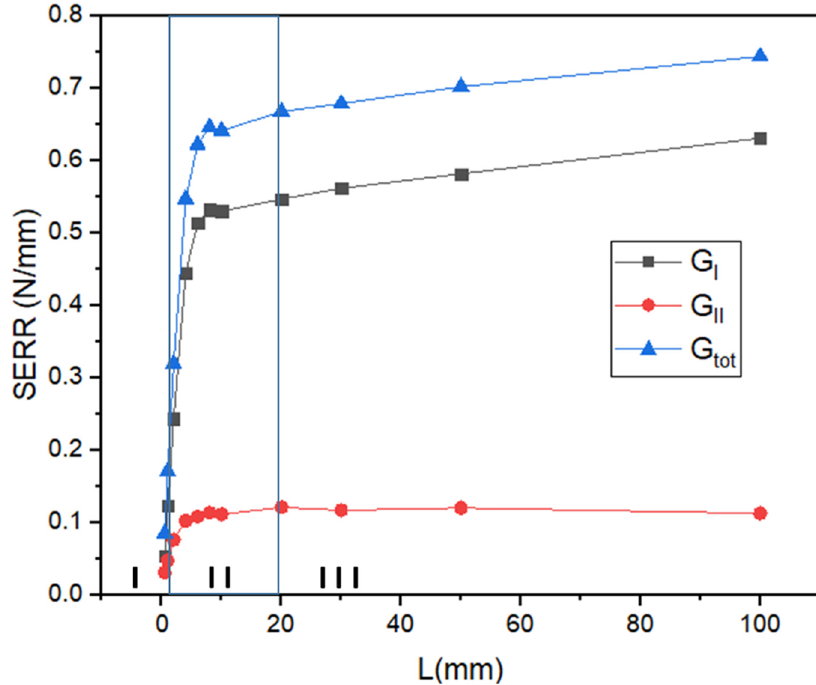
Figure 6. Influence of the SVC on cracking-driving force.